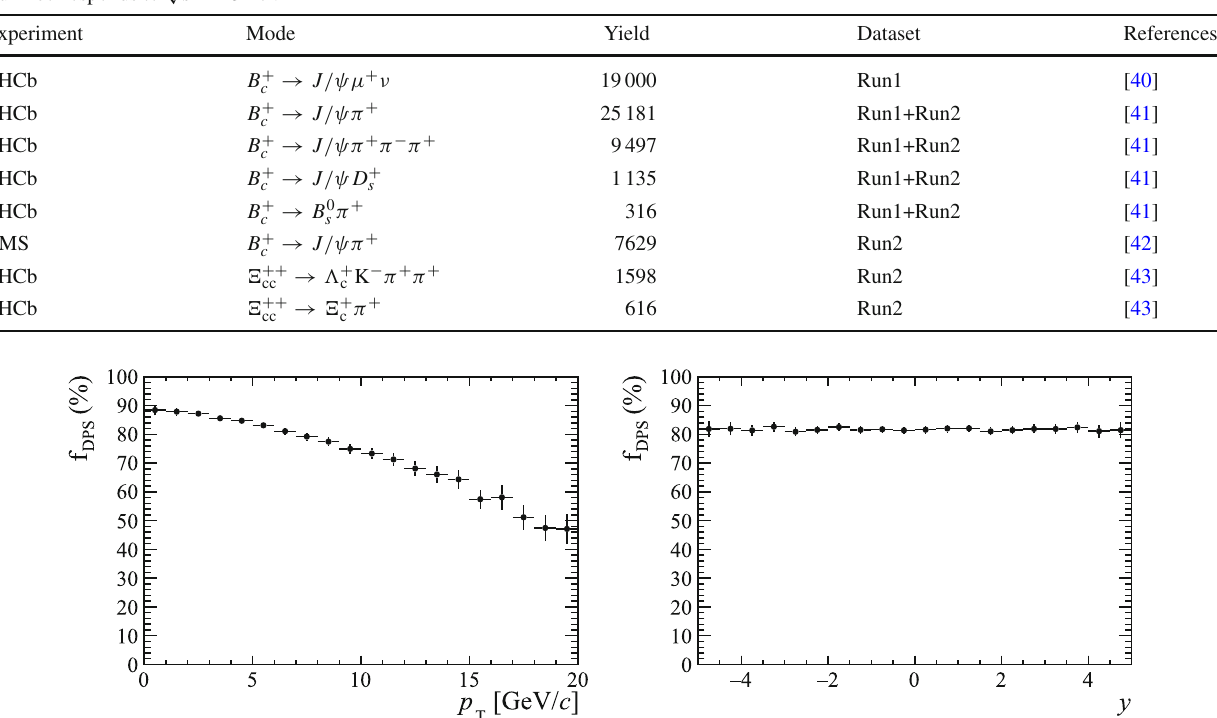
Table 6 Yields of doubly-heavy hadrons reconstructed in recent measurements at the LHC. Run1 corresponds to √ s = 13 TeV Run2 corresponds to